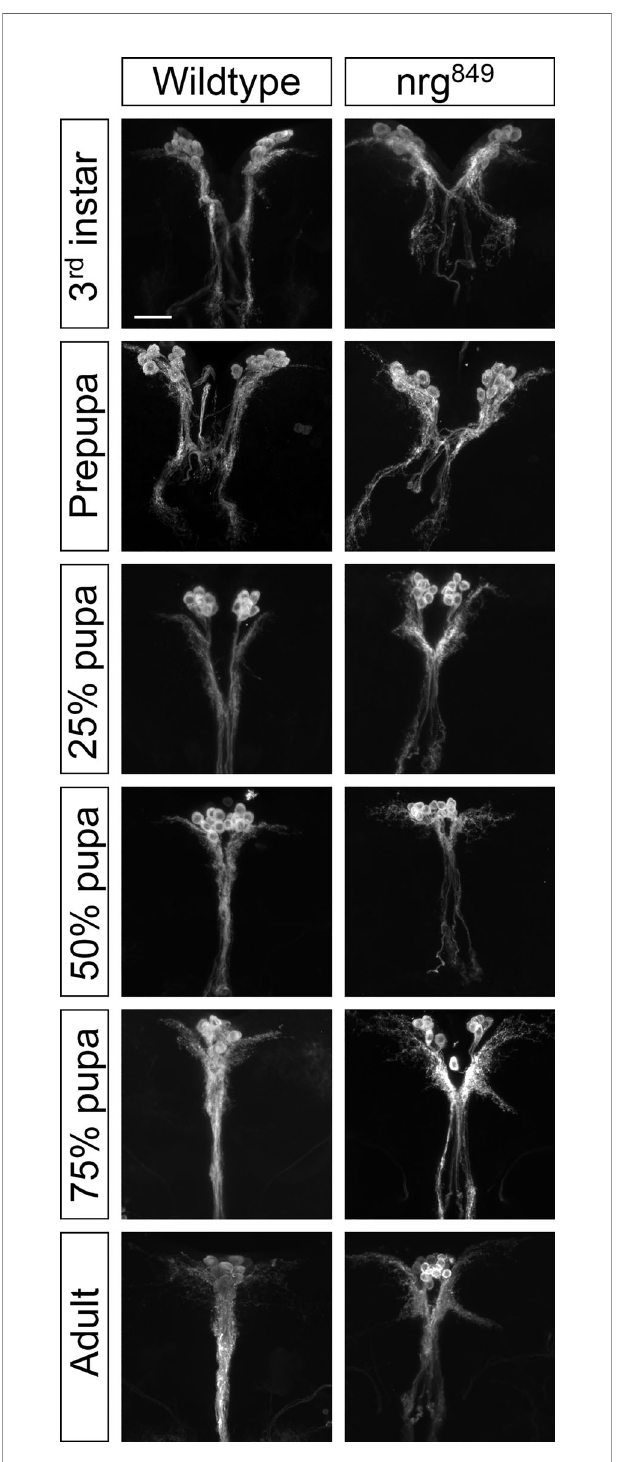
FIGURE 4 | IPC development was studied by imaging the neurons at different stages throughout development (wandering 3 rd instar larvae, prepupa, 25% pupa (24 hours after puparium formation (APF)), 50% pupa (48 hours APF), 75% pupa (72 hours APF), and 3-5 day old adults) of fl ies in which the IPC neurons were labeled via UAS-CD8-GFP driven by Dilp2 Gal4. Scale bar = 25 m